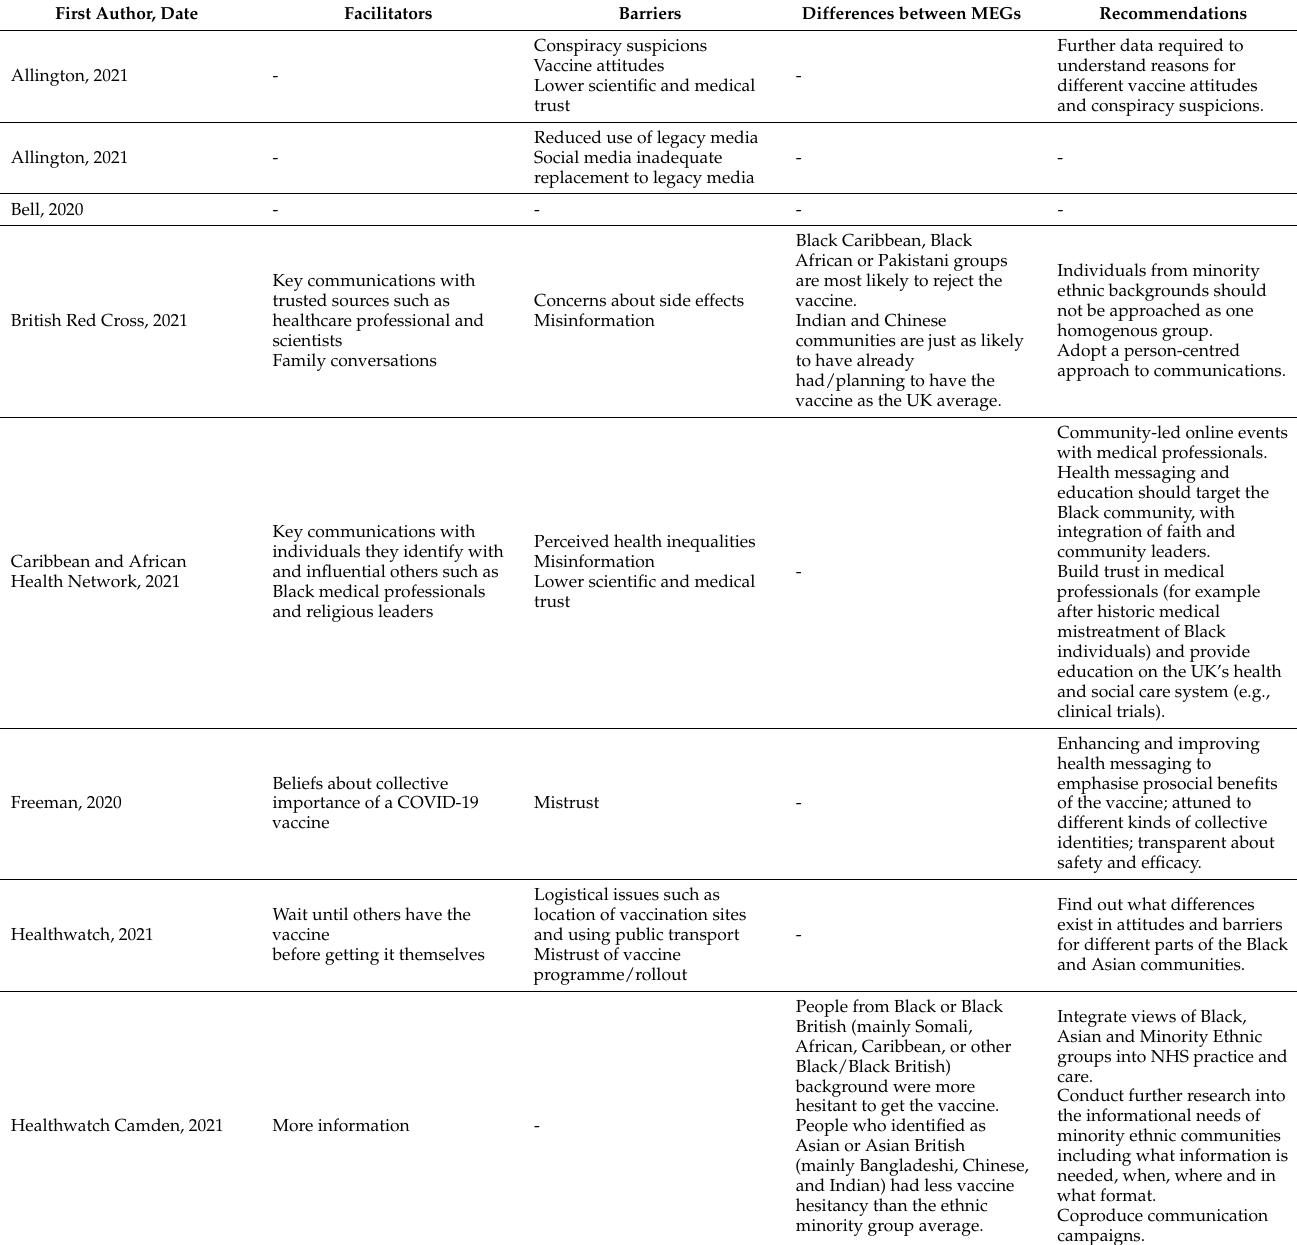
Table 2. Qualitative barriers, facilitators, differences and